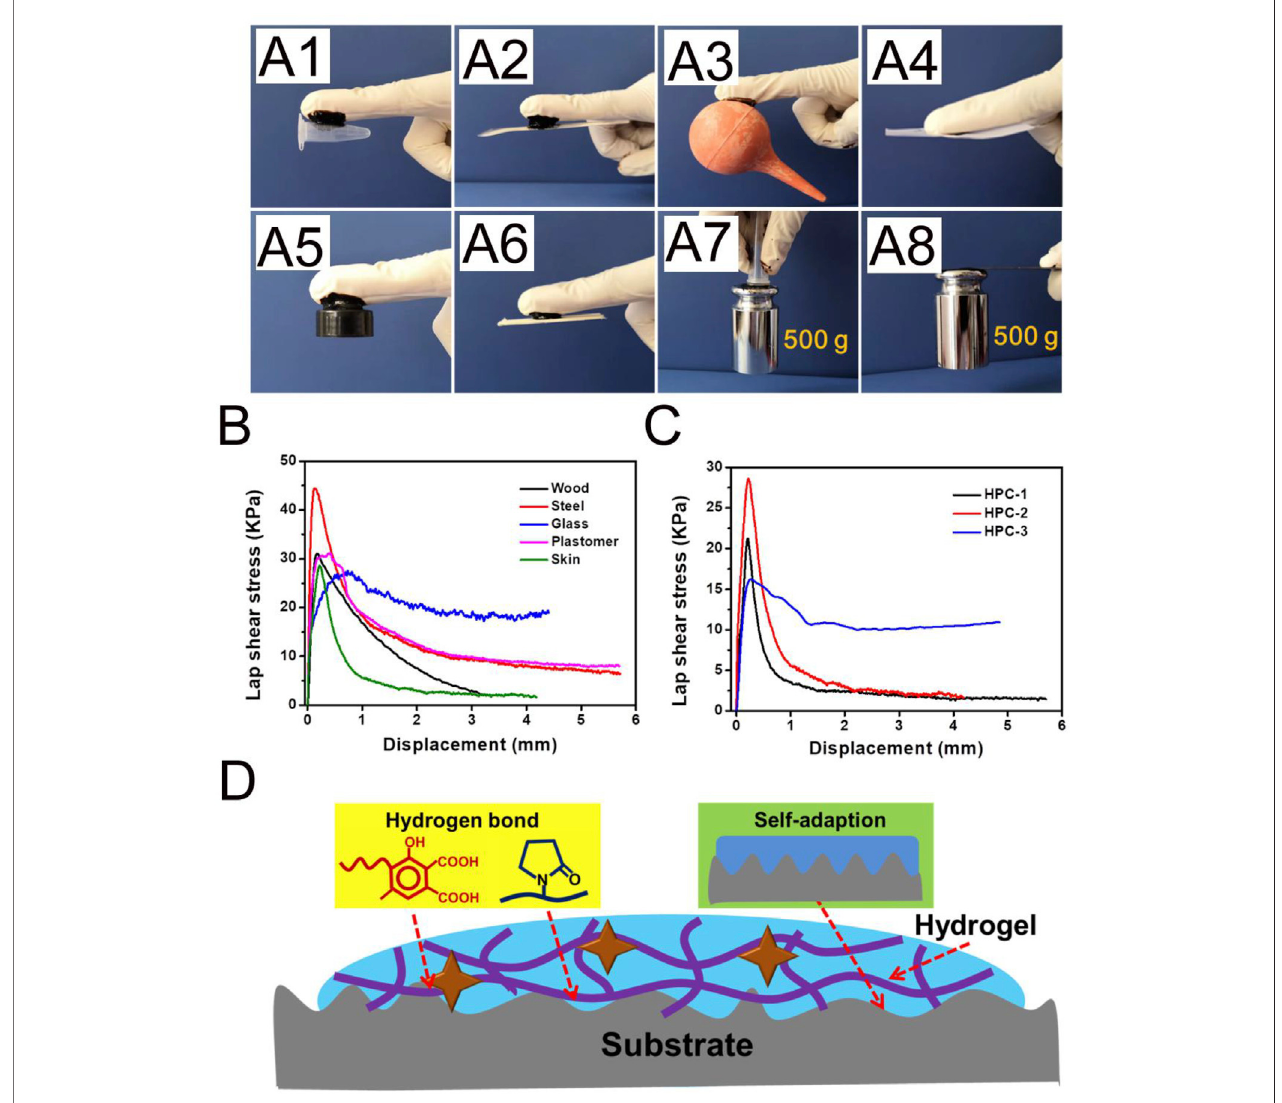
FIGURE 4 | (A) The HPC-2 hydrogel was used as glue to tightly adhere to plastomer, steel, rubber, paper and wood substrates, and put up the weight. (B) Adhesion mechanical curves ofHPC-2 tovarious substrates. (C) Adhesion mechanical curves ofHPC hydrogels toporcineskin. (D) The possible adhesion mechanism of the HPC